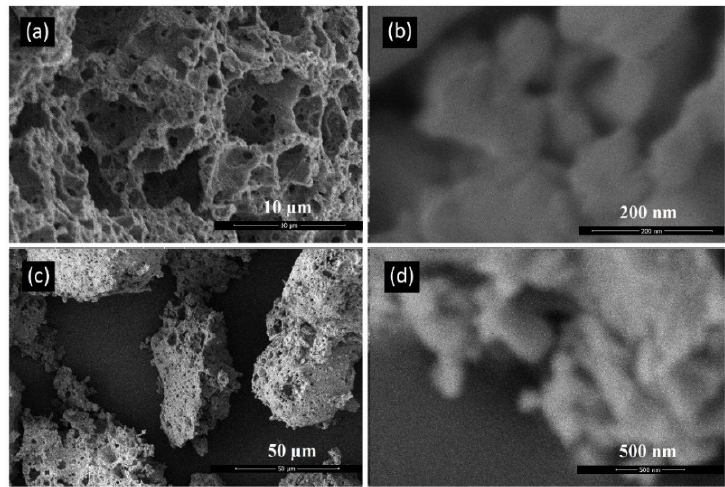
Figure 5. SEM micrographs of akermanite powders produced after ball milling the initial materials for ( a , b ) 10 h and ( c , d ) 20 h with subsequent annealing at 900 ◦ C for 1